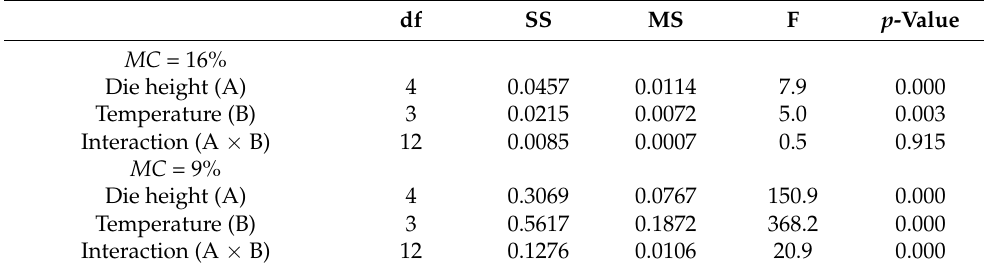
Table 2. Results of ANOVA analysis for density of briquettes in the die ρ 0 at two moisture contents.